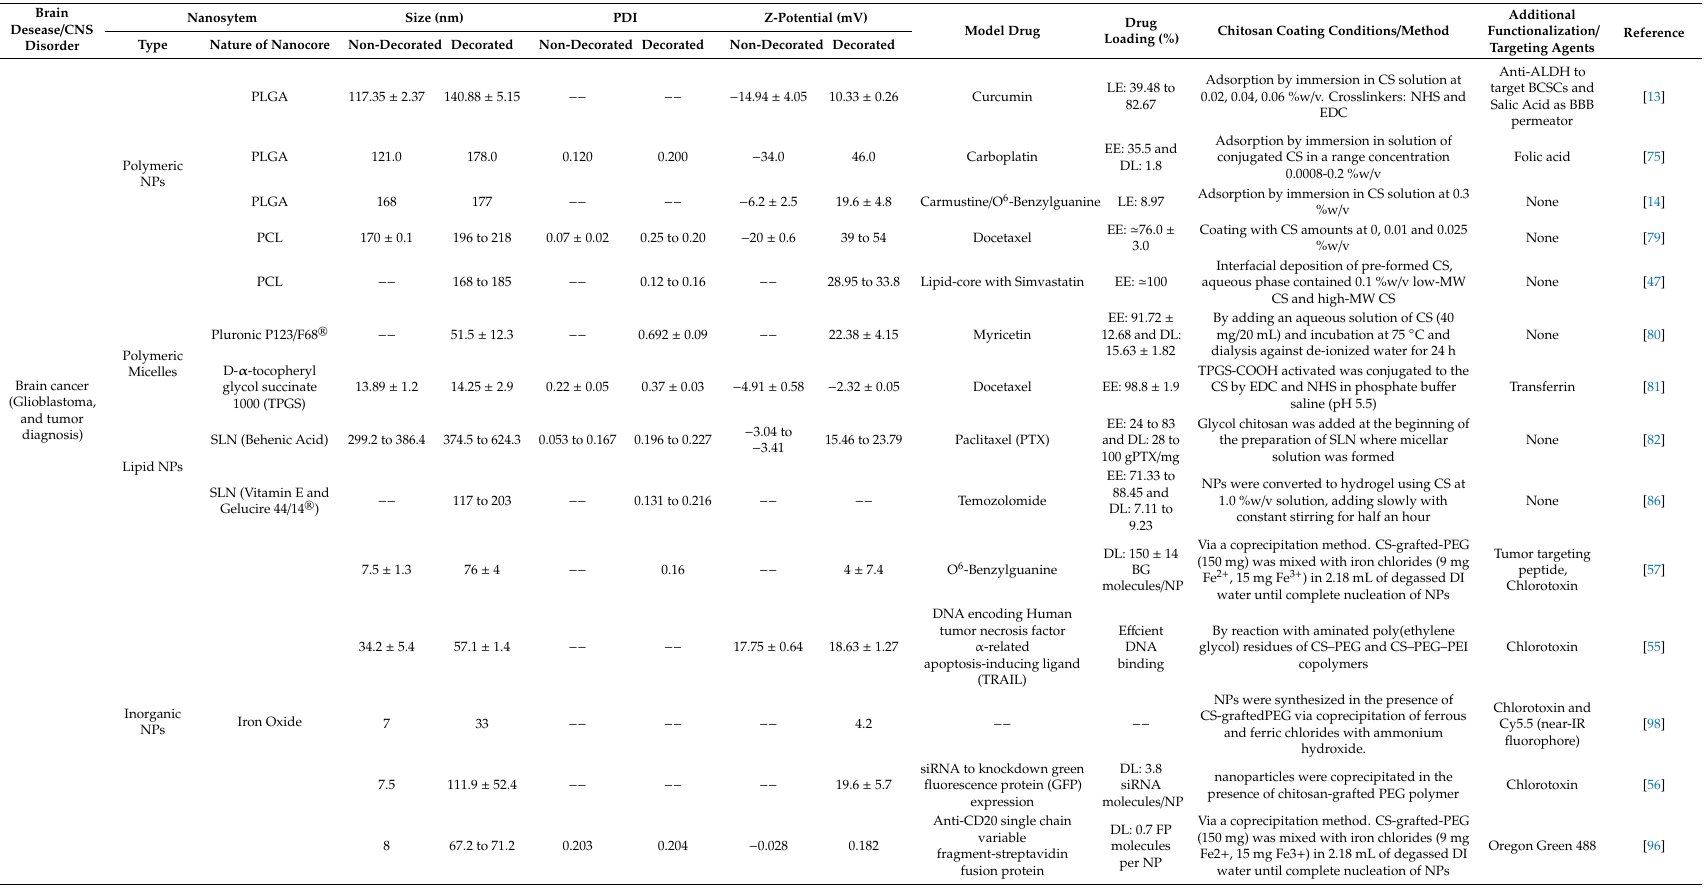
Table 1. Chitosan decorated nanosystems applied to brain and CNS